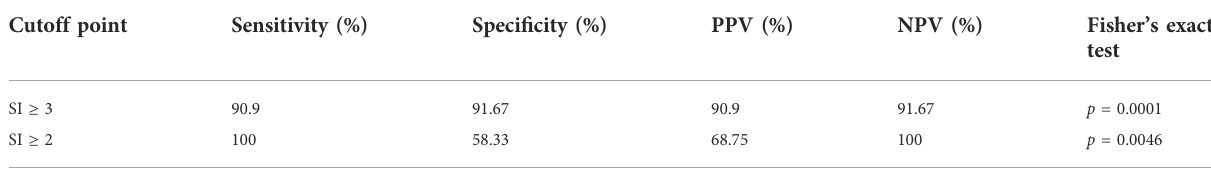
TABLE2Summaryofsensitivityandspeci fi cityofLTTtovancomycinduringtherecoveryphaseofDRESSpatientsaccordingtodifferentcutoffpoints considered for positivity. Cutoff